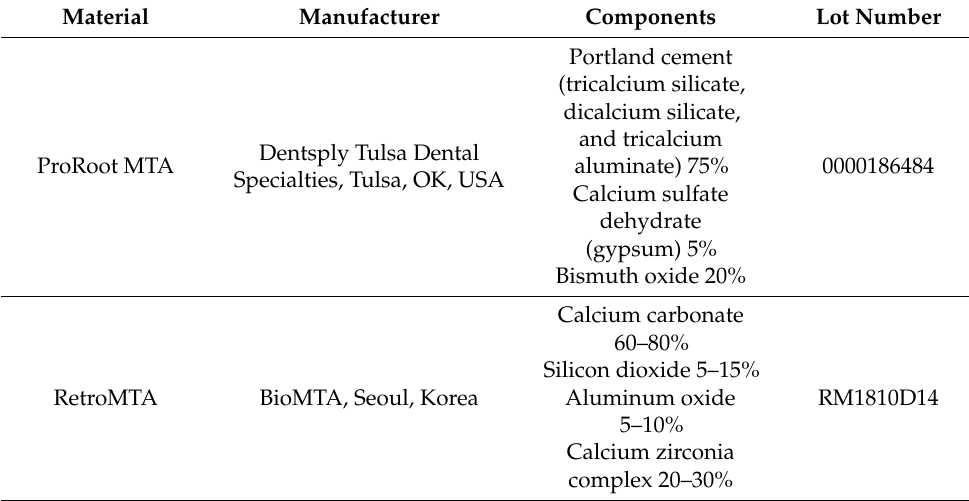
Table 1. Manufacturer and chemical composition of material used in this